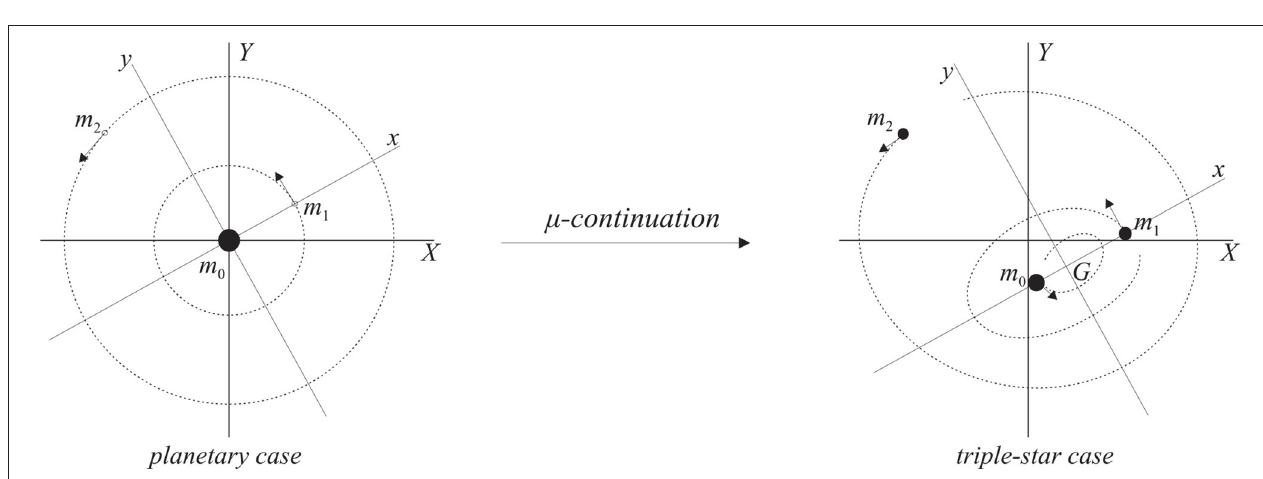
and compute the family of symmetric periodic orbits S ( µ ; a 0 ) in the parameter interval µ ∈ (0, 1]. Since ρ = 1, we pass along the family from a two-planet system to a triple star system and the family ends with m 0 = m 1 = m 2 = 1 / 3 1 . Along continuation we fix the initial position of m 1 , x 10 ≈ 1, and increase the value of the angular momentum, given by Equation (2), proportionally to the increasing masses m 1 and m 2 (Voyatzis, 2017). The variation of the distance parameter a along the family is presented in Figure 3A . As µ increases the distance of the outer body from the inner binary also increases while the normalized period τ decreases accordingly. The eccentricities e 1 and e 2 , which start from zero, vary along the family as it is shown in Figure 3B . region up to µ < 0.1 (the maximum appears for µ = 0.17), but